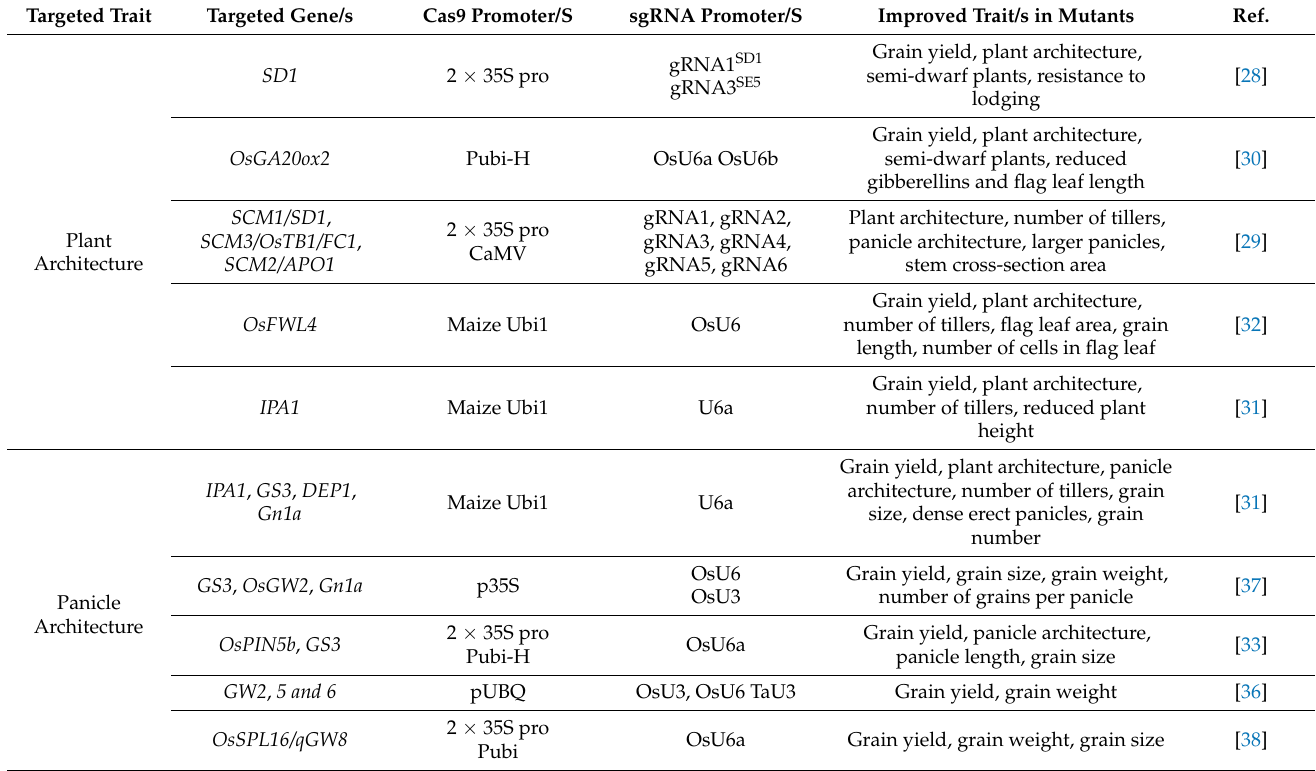
Table 1. Key examples of application of CRISPR/Cas9 system for improving rice grain yield and related traits. Targeted